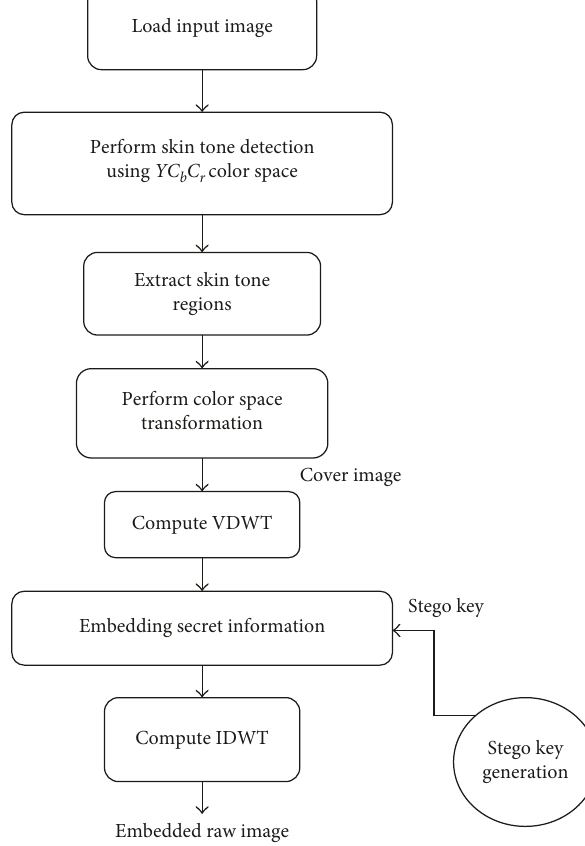
Figure 2: Flow diagram of the embedding